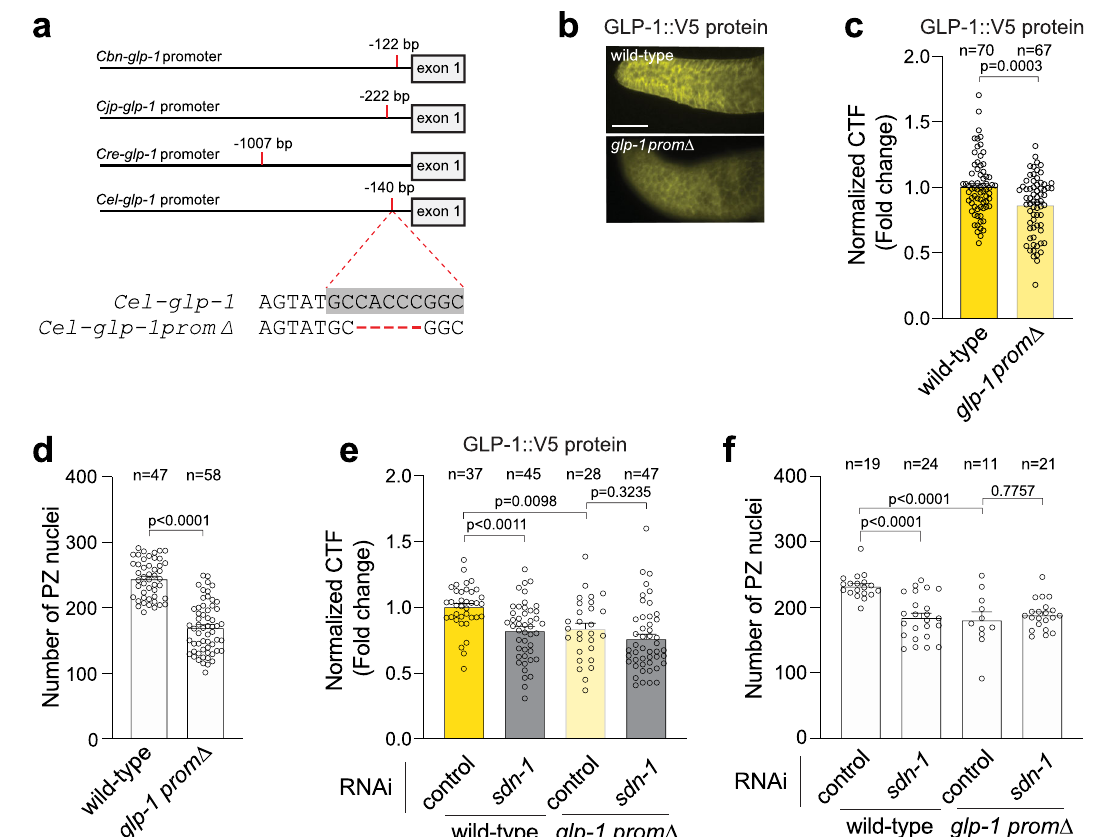
Fig. 3 A conserved promoter motif controls GLP-1 expression and germ cell number. a Location of a conserved motif in the glp-1 promoter of four Caenorhabditis species. Cbn C. brenneri , Cjp C. japonica , Cre C. remanei , Cel C. elegans . The conserved motif in C. elegans glp-1 promoter is highlighted in gray. Deleted bases in CRISPR-engineered glp-1 promoter mutant in red. b , c Immuno fl uorescence images ( b ) and quanti fi cation ( c ) of GLP-1::V5 protein in the distal germline of wild-type and glp-1prom Δ (5 bp deletion in conserved promoter motif) adult hermaphrodites. Data were expressed as mean ± s.e.m. and statistical signi fi cance was assessed by unpaired t -test. Scale bar = 10 µ m. d Quanti fi cation of PZ nuclei of wild-type and glp-1prom Δ adult hermaphrodites. Data were expressed as mean ± s.e.m. and statistical signi fi cance was assessed by a two-tailed unpaired t -test. e Quanti fi cation of GLP-1::V5 protein in the distal germline of adult hermaphrodites (± sdn-1 RNAi) expressing wild-type glp-1 or glp-1prom Δ adult hermaphrodites. Data were expressed as mean ± s.e.m. and statistical signi fi cance was assessed by ordinary one-way ANOVA. f Quanti fi cation of PZ nuclei in the distal germline of